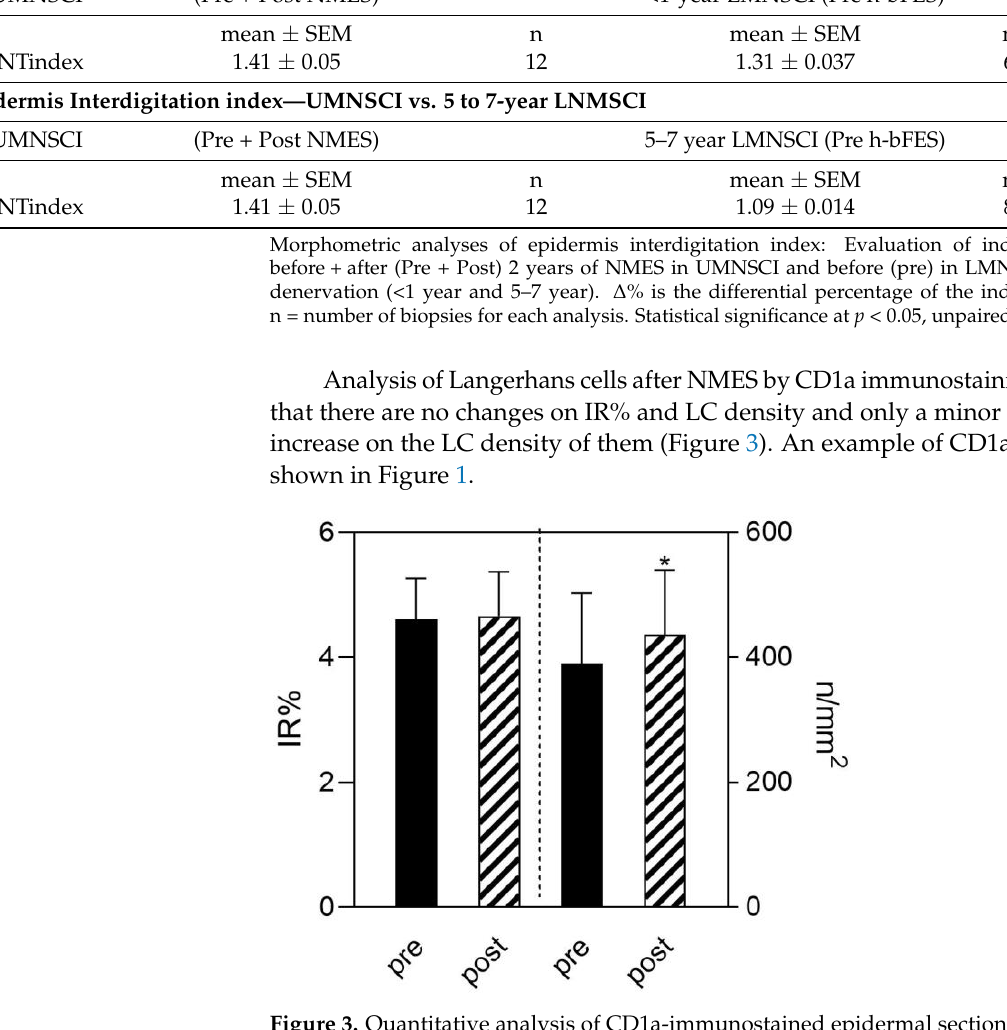
Figure 4. Langerhans cells (CD1a positive) in UMNSCI vs LMNSCI: Quantitation in immunostained epidermal sections of CD1a before + after (Pre + Post) 2 years of NMES on UMNSCI and before (pre) in LMNSCI. IR% is the percentage of immunoreactivity for CD1a; n/mm 2 is the number of LC bodies per square millimeter of epidermis; data are mean ± SEM; statistical significance at p < 0.05 (*) p < 0.0001 (**), unpaired t test.